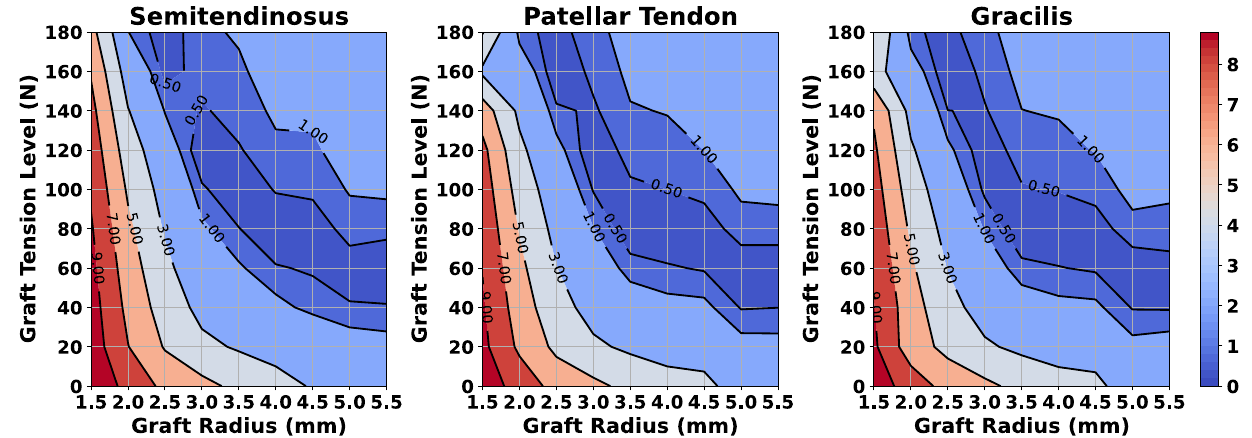
Figure 8. Comparison of three graft materials for different pretension and graft radius values. The absolute difference in relative knee displacement between each ACLR FE model and the RM was annotated using contour lines. Combinations of graft tension and graft radius that are close to the RM are inside the area with an absolute difference below 0.5, highlighted with dark blue color.